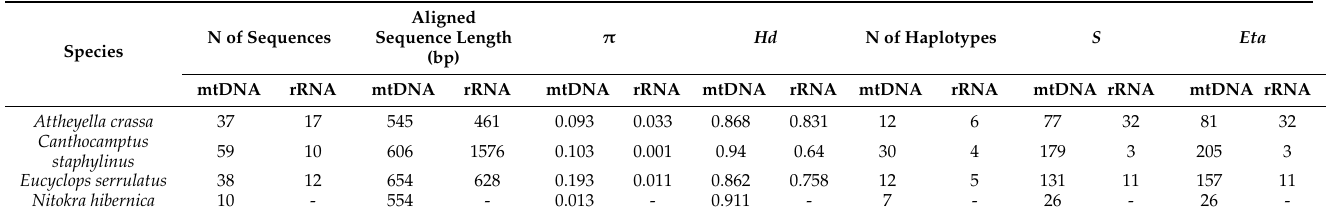
Table 1. Number ( N ) and lengths of analyzed sequences (alignments), nucleotide diversity ( π ), haplotype diversity ( Hd ), number of different haplotypes ( h ), number of polymorphic sites (S) and mutations (Eta) for the studied species.